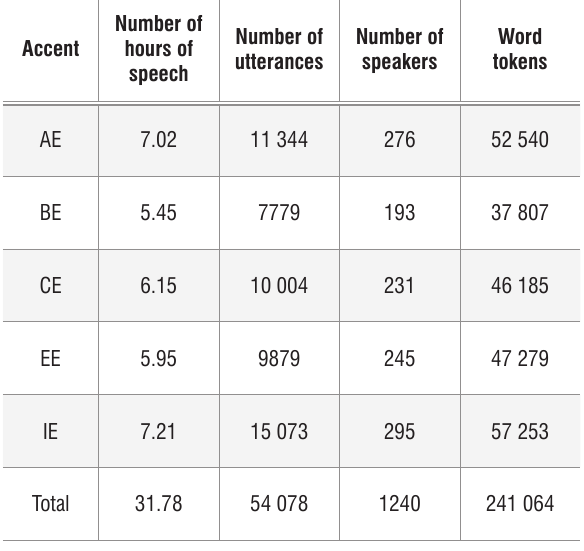
Table 1: Training sets for each South African English accent